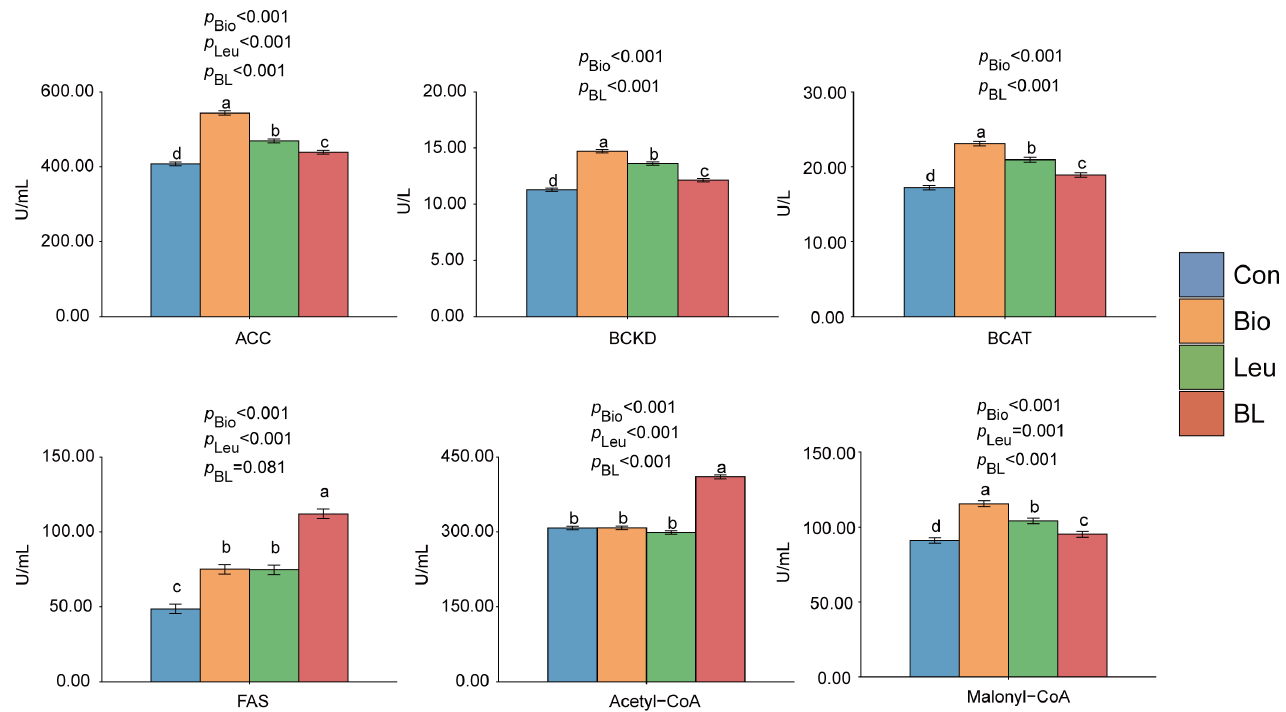
Figure 3. Effects of biotin and leucine supplementation on the activities of fatty acid synthesis related enzymes in vitro. Con, control group; Bio, biotin supplemented group; Leu, leucine supplemented group; BL, biotin and leucine combination group; ACC, acetyl-CoA carboxylase; BCKD, branched-chain α -keto acid dehydrogenase; BCAT, branched-chain amino acid aminotransferase; FAS, fatty acid synthase. Columns labeled with different letters are significantly different ( p < 0.05).